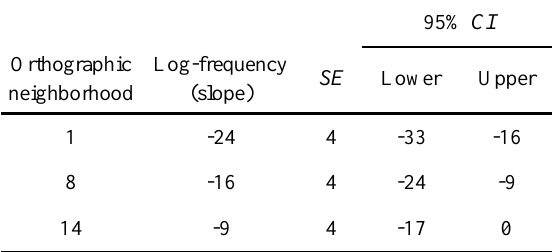
Table A4. Gaze duration: Interaction of lexical frequency and orthographic-neighborhood